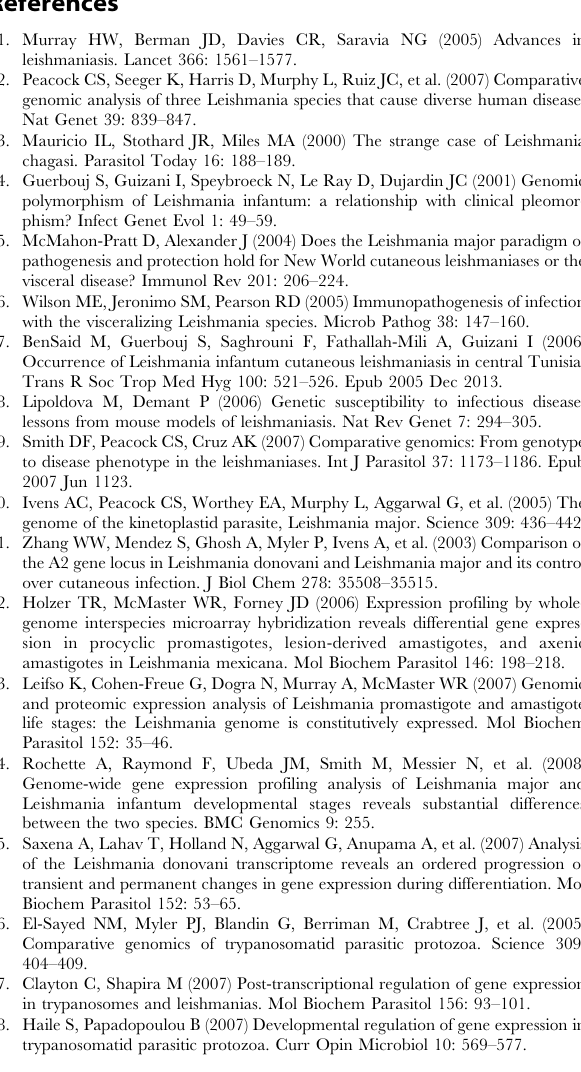
Table S4 Genes differentially expressed between amastigotes of three Leishmania species. Table S5 Leishmania genes demonstrating stage regulation in one or more